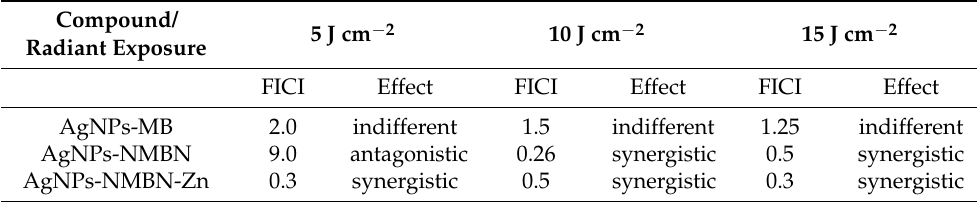
Table 3. Fractional inhibitory concentration index (FICI) of APDT with AgNPs-PS in C. albicans . Compound/